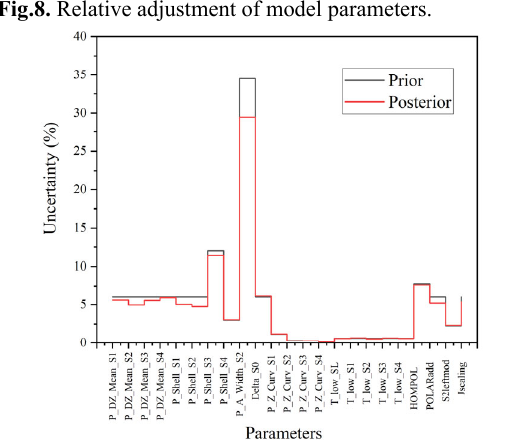
Fig.8. Relative adjustment of model parameters.